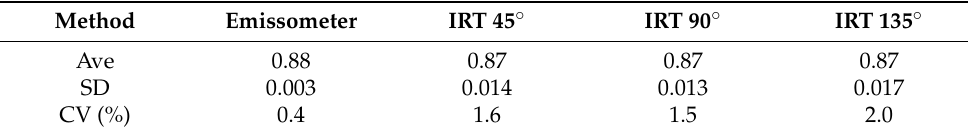
Table 6. Emissivity values obtained with the emissometer and IRT (three different